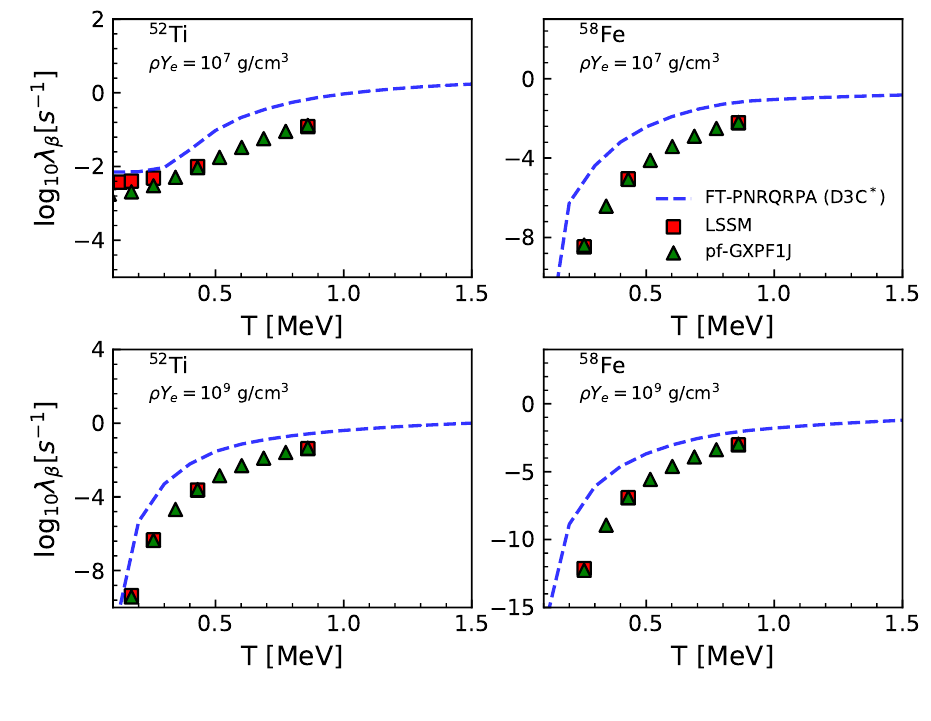
Figure 2. The same as Fig. 1 but for β -decay rate λ β